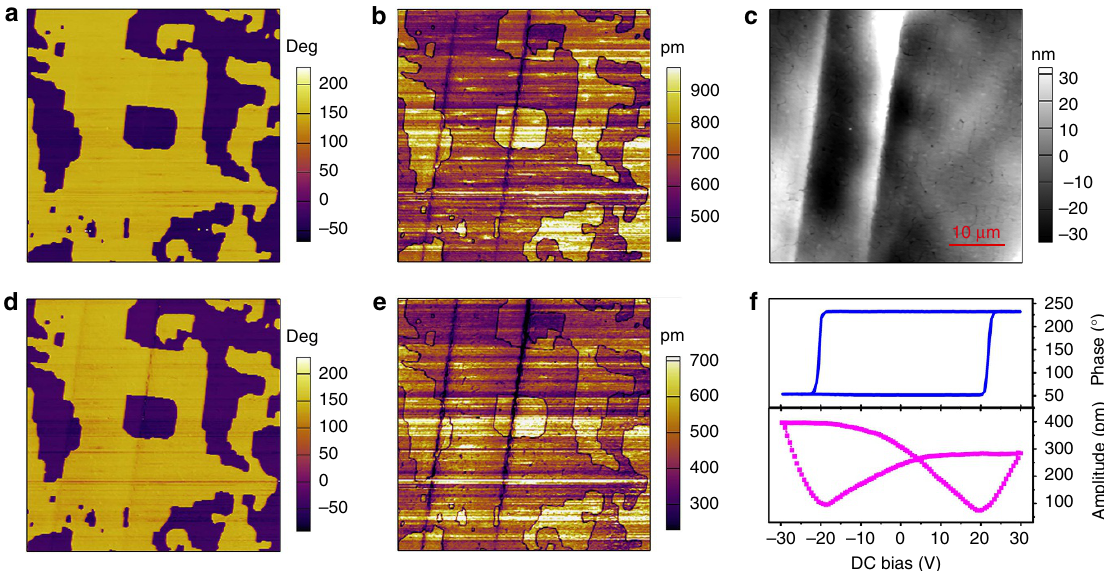
Figure 7 | Domain structures observed for a thin film of 1. ( a ) The vertical PFM phase image. ( b ) The vertical PFM amplitude image. ( c ) The topographic image of the film surface. ( d ) The lateral PFM phase image. ( e ) The lateral PFM amplitude image. ( f ) The phase and amplitude signals as functions of the tip voltage for a selected point, showing local PFM hysteresis loops.